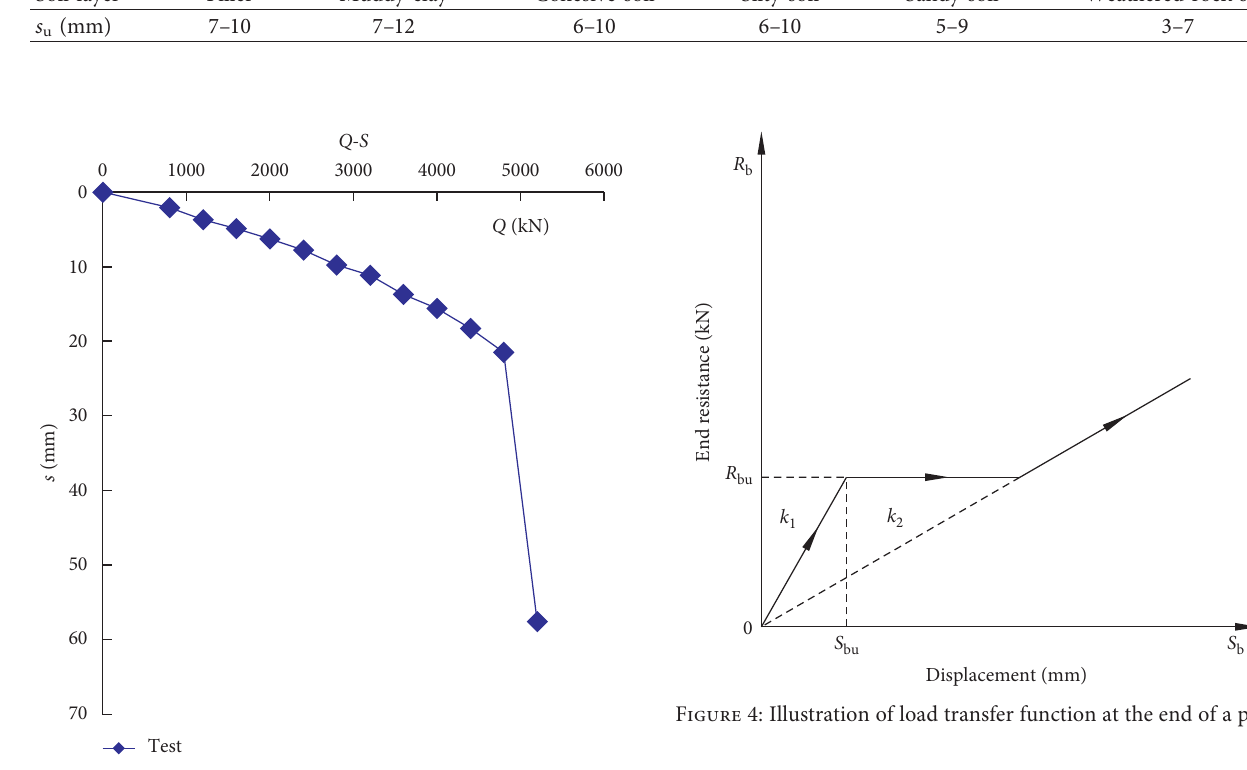
Figure 3: Q - S curve.